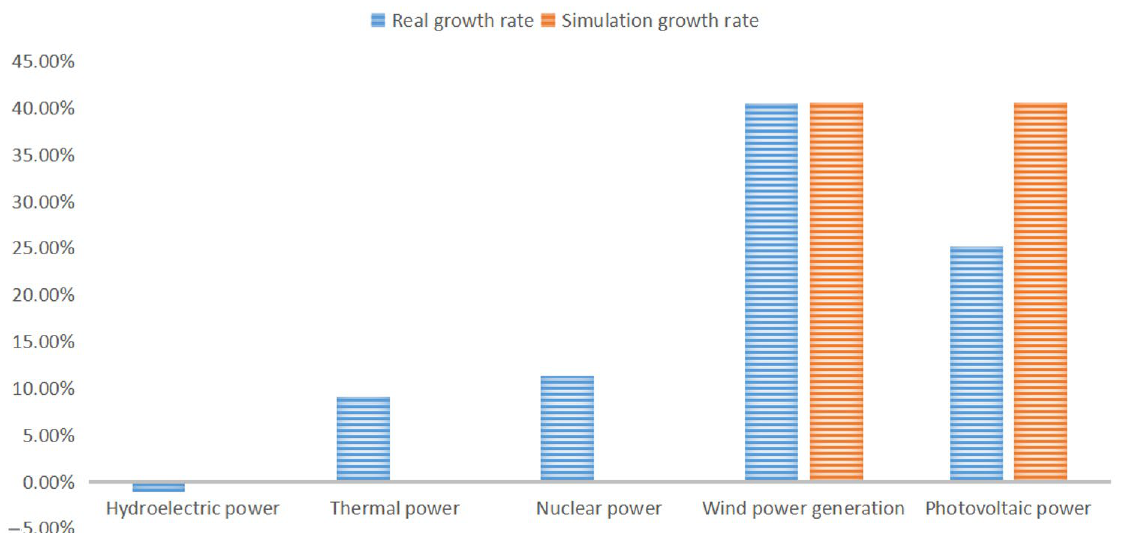
Figure 9. Comparison of energy development in 2021 .